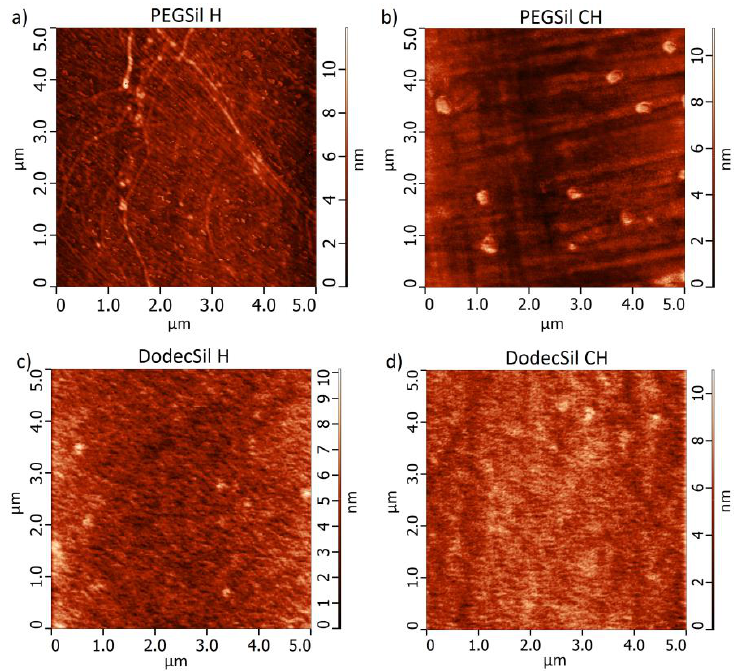
Figure 2. Atomic force microscopy (AFM) height images from 5 × 5 μm areas between the electrodes of ( a ) PEGSil H; ( b ) PEGSil CH; ( c ) DodecSil H; ( d ) DodecSilCH.